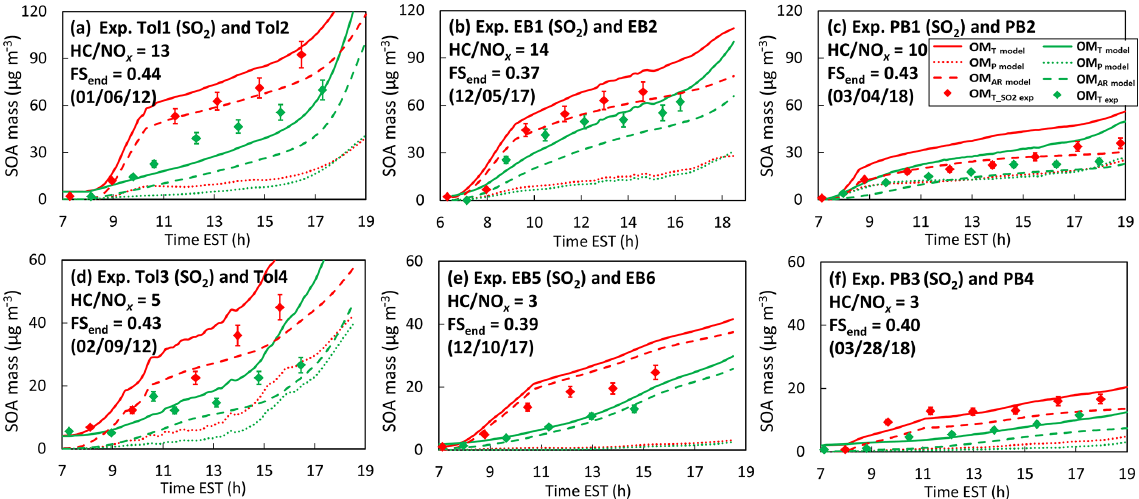
Figure 6. Time profiles of measured and modeled SOA mass concentrations (µgm − 3 ) for toluene, ethylbenzene, and n -propylbenzene SOA under low-NO x (a–c) /high-NO x (d–f) conditions in the presence (red color)/absence (green color) of SO 2 -derived sulfuric-acid-seeded aerosol. Solid, dashed, and dotted lines denote the total organic matter (OM T ), the OM from partitioning only (OM P ), and the OM from the aerosol-phase reactions (OM AR ), respectively. The degree of ammonia neutralization with sulfuric acid is indicated by the FS end , which is the FS at the end of the experimental run. The FS end ranges from 1 (for sulfuric acid) to 0.33 (for ammonium sulfate). The uncertainty associated with experimentally measured OM is about 9%. The SOA mass was corrected for the particle loss to the chamber wall. The experimental conditions are available in Table